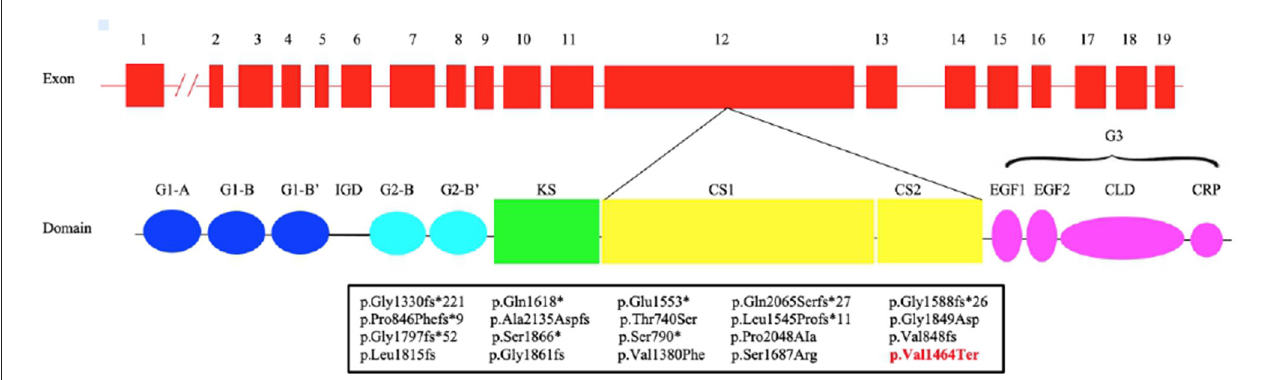
FIGURE 1 | Structure of ACAN gene and aggrecan protein. Pathogenic variants in exon 12 (bottom) with respective predicted changes in the amino acid sequence are shown. The mutations identified in previous studies are shown in black, while our is in red. CLD, C-type lectin domain; CRP, complement regulatory protein-like domain; CS1, chondroitin sulfate 1; CS2, chondroitin sulfate 2; EGF1, 2, epidermal growth factor–like domain 1, 2; G1, globular domain 1; G2, globular domain 2; G3, globular domain 3; IGD, interglobular domain; KS, keratan